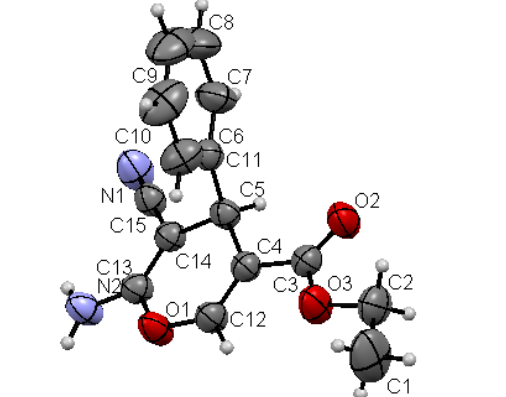
Figure 6. X-ray crystal structure of ( R )-ethyl-6-amino-5-cyano-4-pheny l -4 H -pyran-3- carboxylate 13